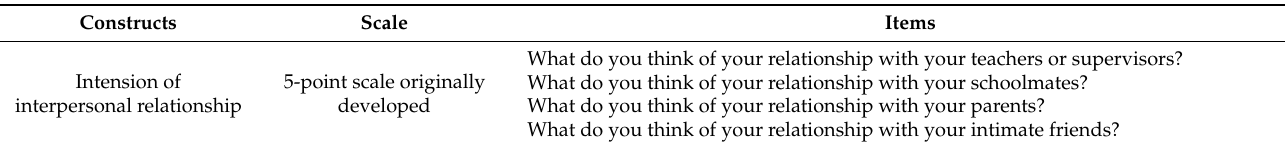
Table A1. Survey items in our